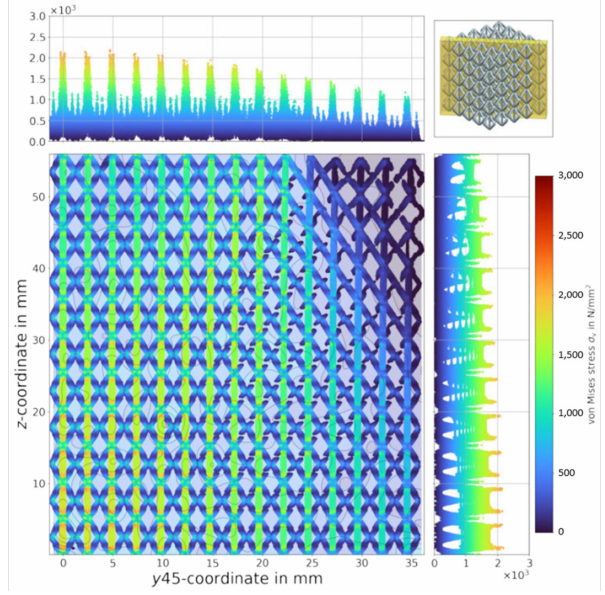
Figure 10. Von Mises stress of f2ccz sample 10—diagonal view cut.